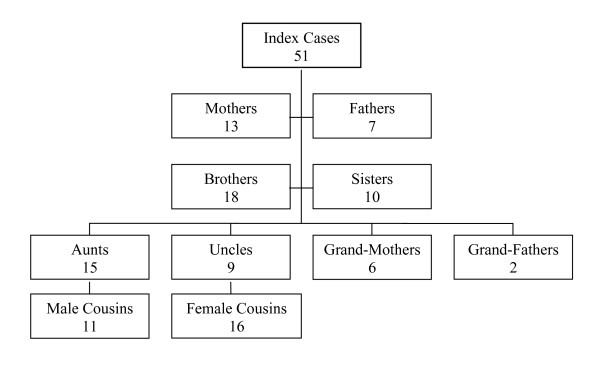
Pertussis cases among relatives of the index cases.